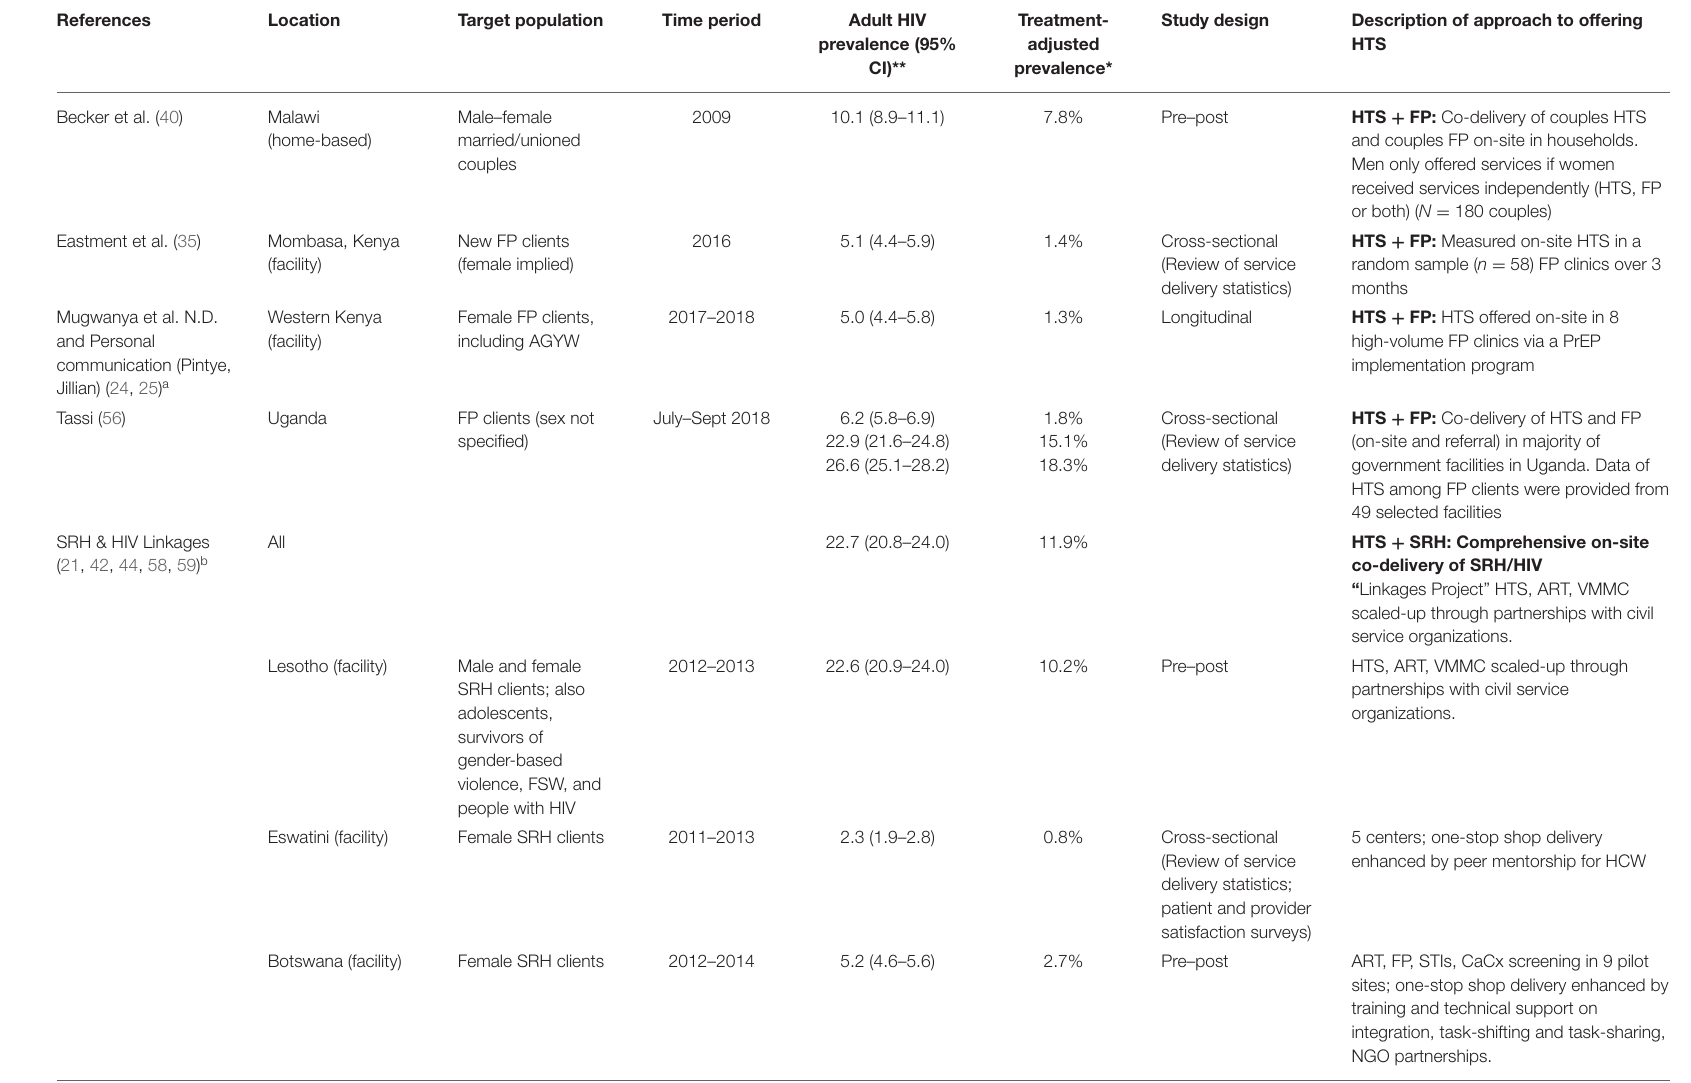
TABLE 1 | Characteristics of included programs/studies from sub-Saharan African countries, by